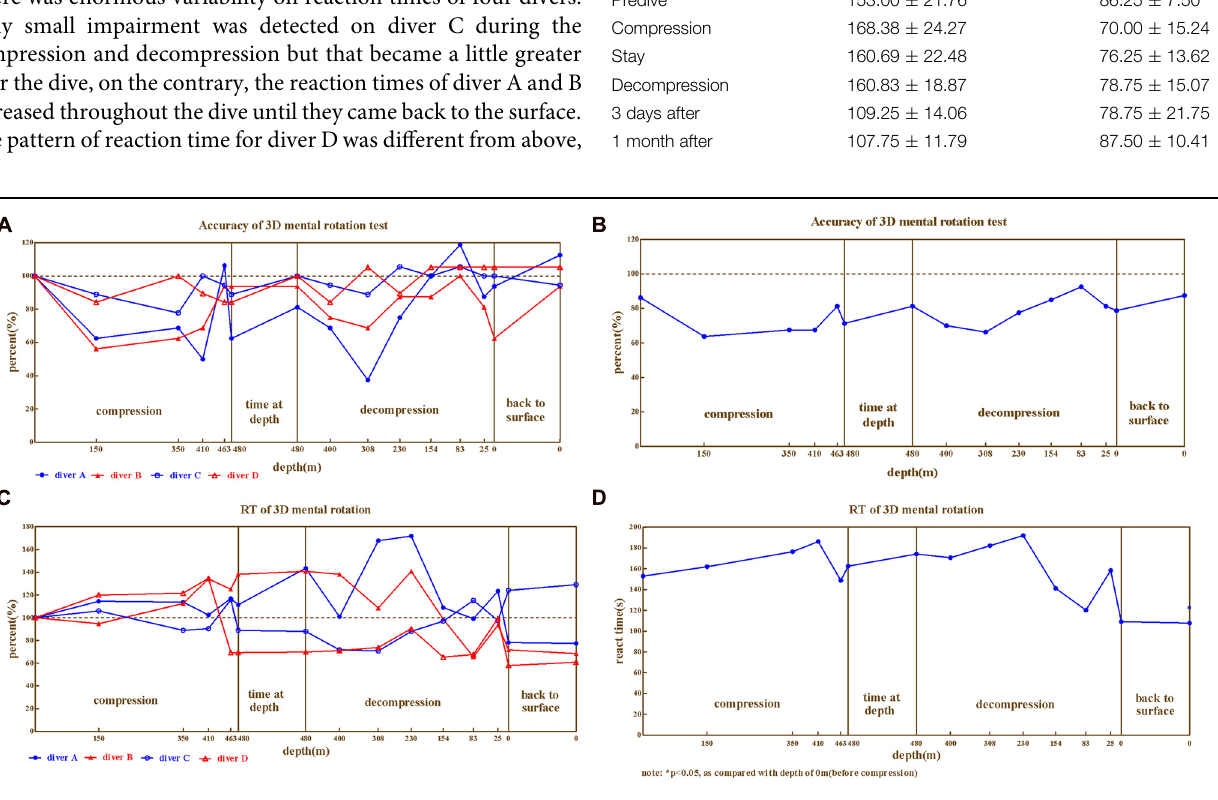
Frontiers in Psychology |